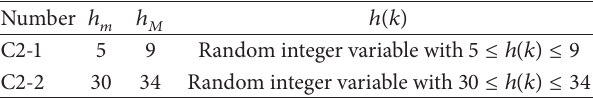
Table 4: The conditions of simulation in Example